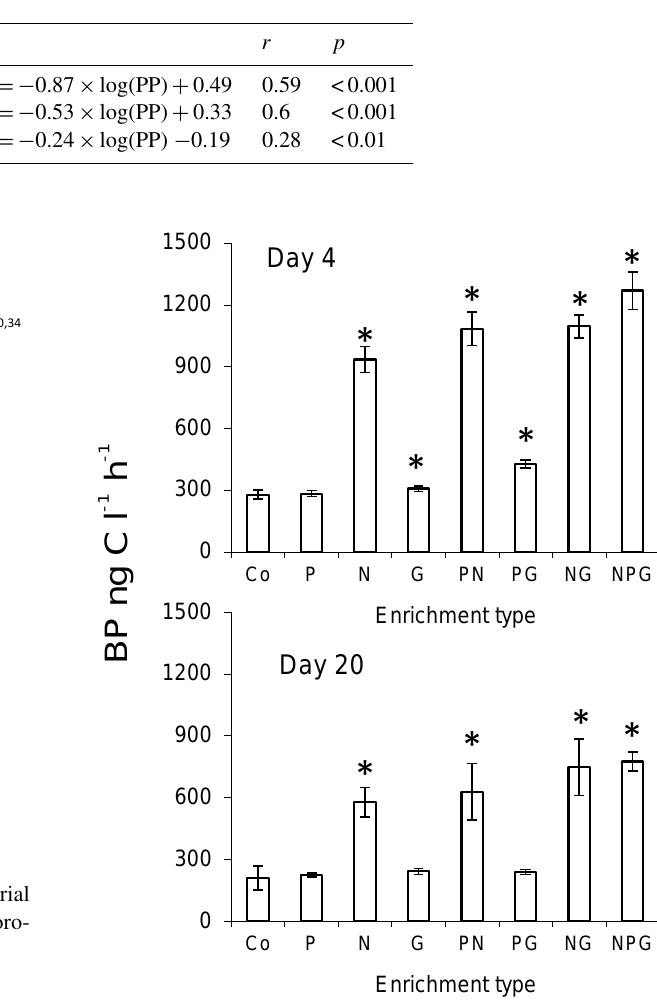
Figure 5. Response of heterotrophic bacterial production to the en- richment experiments conducted on days 2 and 20. Asterisks show significant responses in comparison to the unamended control (Co) after the Mann–Whitney test ( ∗ : p